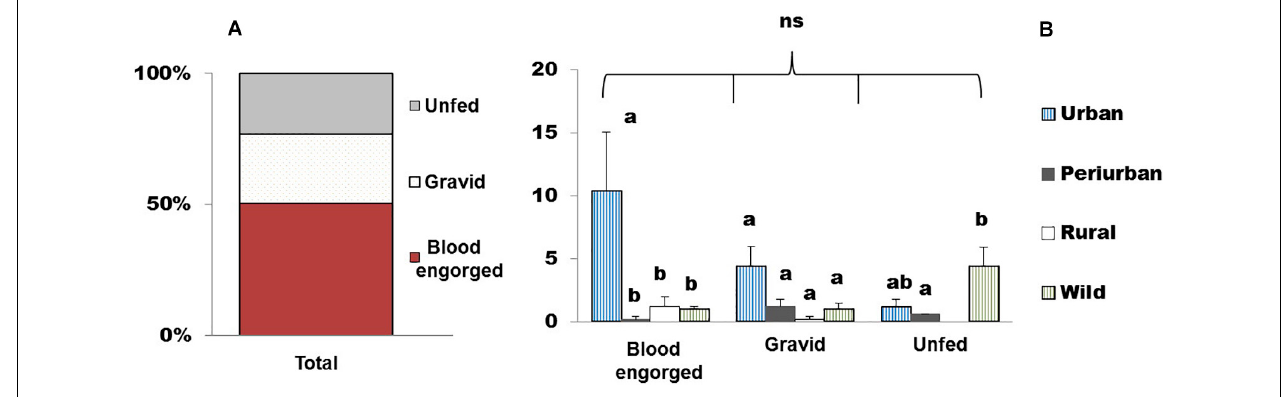
FIGURE 3 | Distribution of gonotrophic stages in female mosquitoes in the four sampling habitats (A) Total frequency of gonotrophic stages (blood-engorged, gravid, and unfed). (B) Abundance (Mean + SEM) of gonotrophic stages per habitat. Columns with different letters (a,b) within each gonotrophic stage are statistically different, while “ns” denotes non-significant differences in the total number of females between gonotrophic stages (Kruskal–Wallis test followed by Mann–Whitney U test).